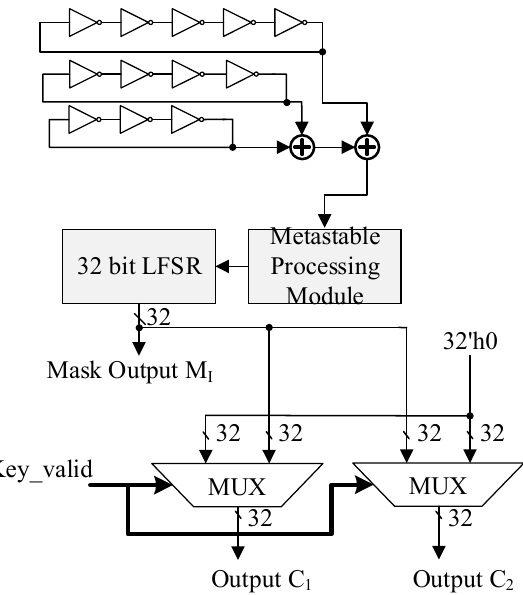
Figure 6. Circuit diagram of random mask generation module.